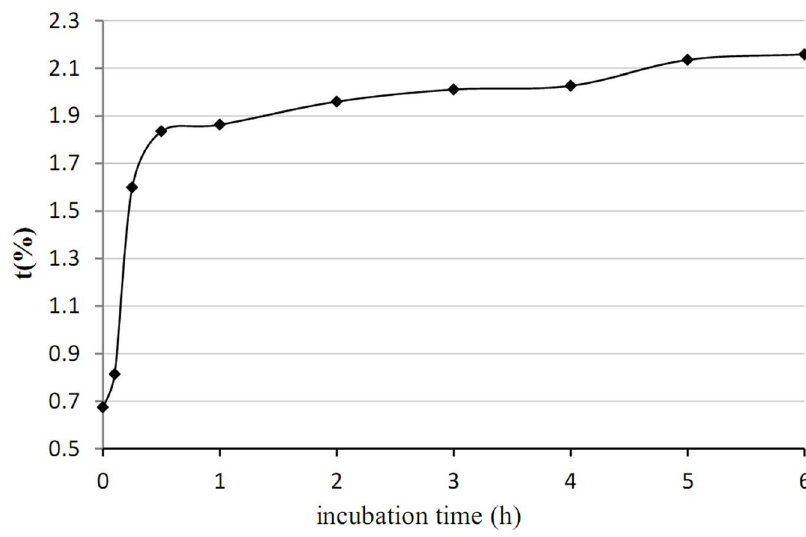
Figure 7. t (%) value of aggregates obtained at different incubation times.